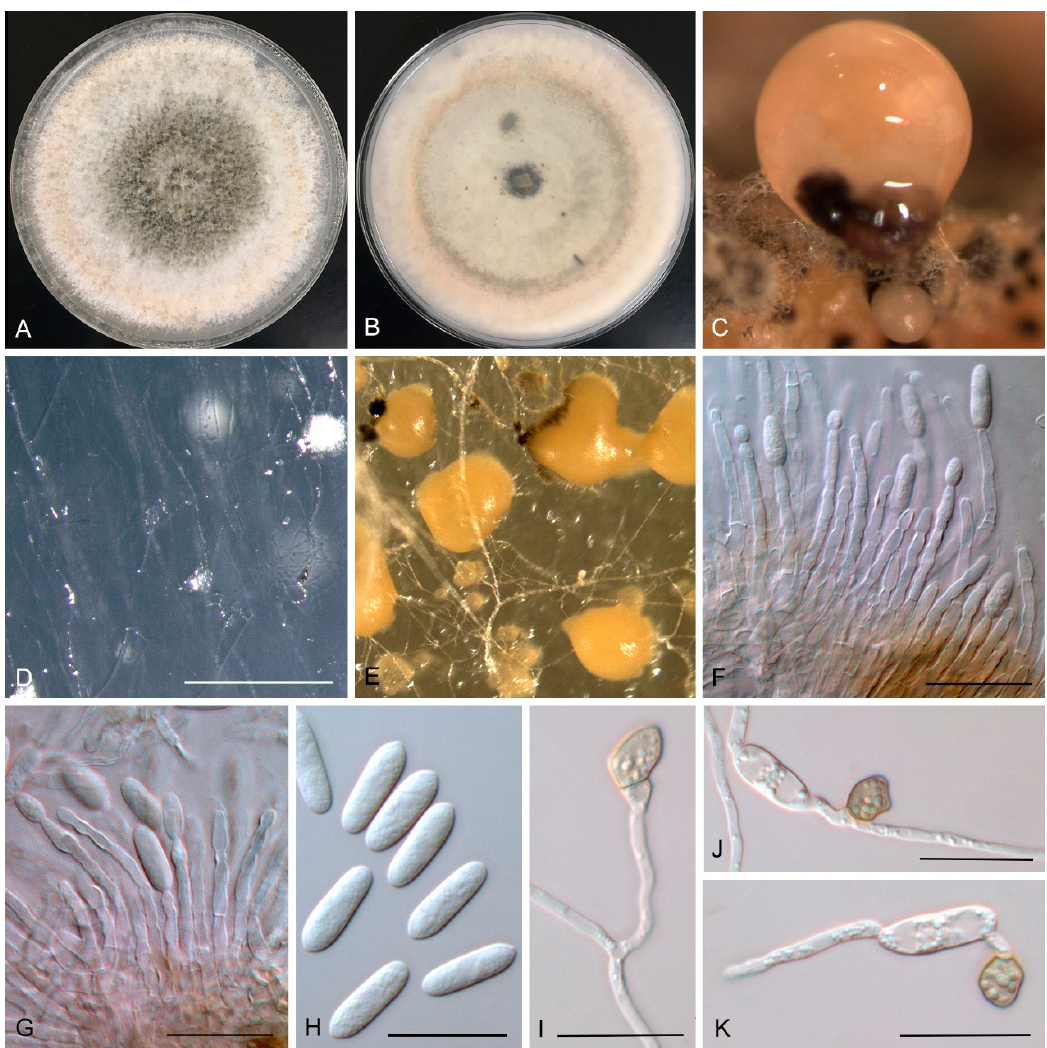
Figure 5. Morphological characteristics of Colletotrichum australianum sp. nov.: One-week-old culture on PDA ( A , B ), conidiomata on mandarin rind ( C ), conidiomata on SNA ( D ), conidiomata on PDA ( E ), conidiophores ( F , G ), conidia ( H ) and appressoria ( I – K ). Scale bars: D, 500 µm; F, G, H, I, J, K, 20 µm.